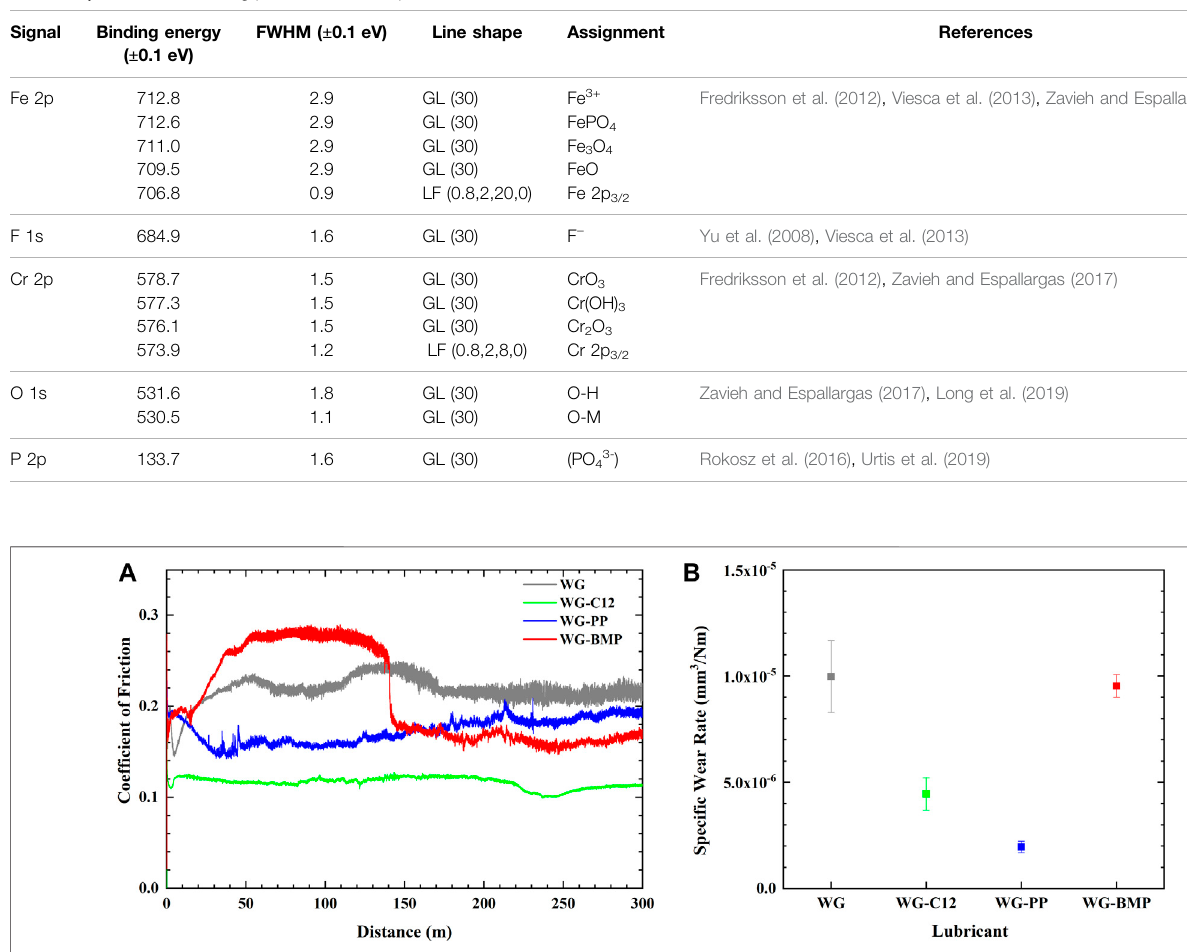
Frontiers in Mechanical Engineering |